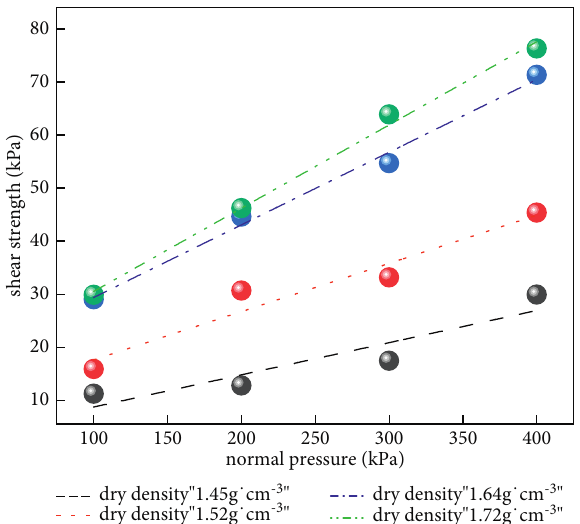
Figure 4: Relationship between normal pressure and shear strength of silty clay. Table 5: Linear fitting parameters of the relationship between normal pressure of different dry densities and shear strength. Dry density (g · cm − 3 ) Fitting curve 1.45